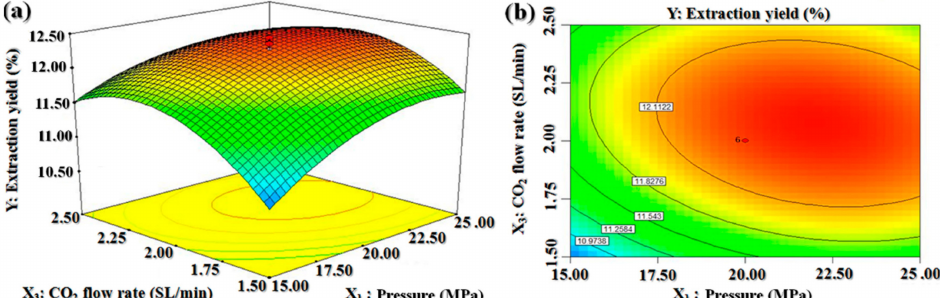
Figure 3. Response surface ( a ) and contour plots ( b ) for the e ff ect of pressure and CO 2 flow rate on the B. dasystachya seed oil yield.